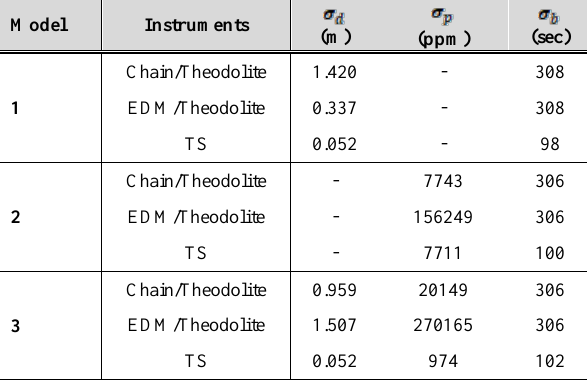
Table 4. Results of VCE for traverse network Dataset 2 using